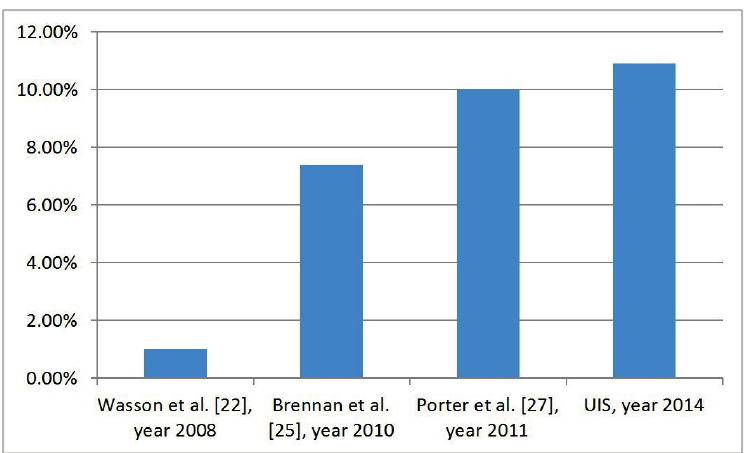
Figure 17. Comparison of the proportion of vehicles detected using Bluetooth according to different